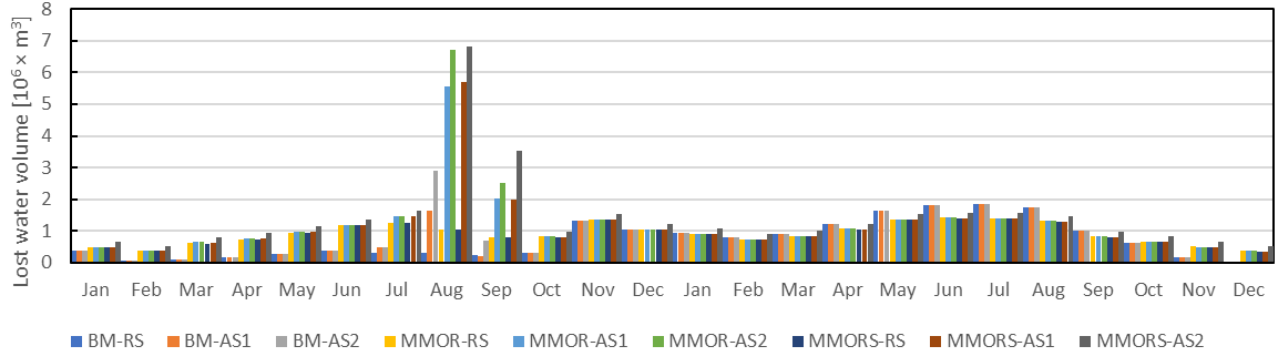
Figure 8. Energy production per month for each model variant and input scenario.